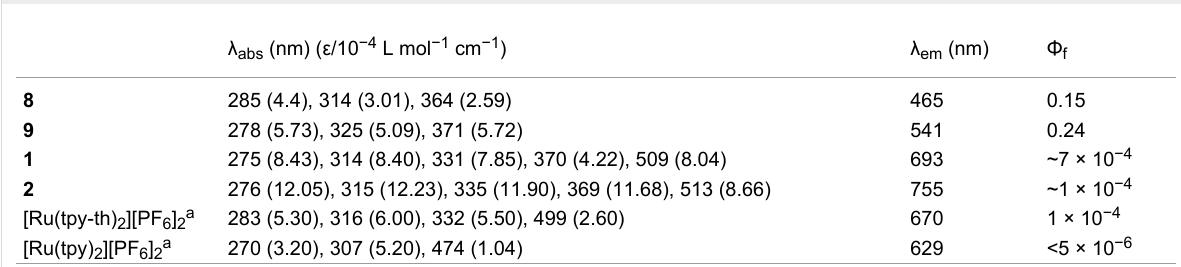
Table 1: Absorption, fluorescence and quantum yield data for the ligands and complexes in acetonitrile